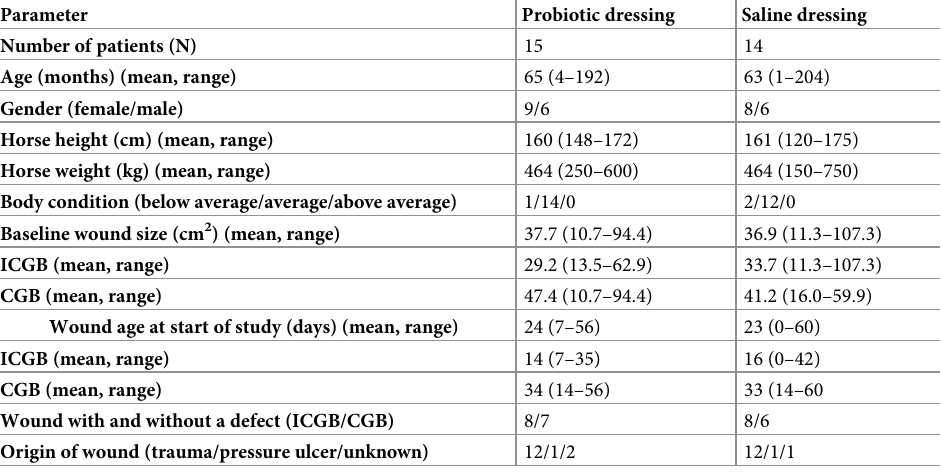
Table 1. Patient demographics and baseline wound recordings of the 29 warmblood horses included in the study. Parameter Probiotic dressing Saline dressing Number of patients (N) 15 14 Age (months) (mean, range) 65 (4–192) 63 (1–204) Gender (female/male) 9/6 8/6 Horse height (cm) (mean, range) 160 (148–172) 161 (120–175) Horse weight (kg) (mean, range) 464 (250–600) 464 (150–750) Body condition (below average/average/above average) 1/14/0 2/12/0 Baseline wound size (cm 2 ) (mean, range) CGB (mean, range) Wound age at start of study (days) (mean, range) 24 (7–56) 23 (0–60) ICGB (mean, range) 14 (7–35) 16 (0–42) CGB (mean, range) 34 (14–56) 33 (14–60 Wound with and without a defect (ICGB/CGB) 8/7 8/6 Origin of wound (trauma/pressure ulcer/unknown) 12/1/2 12/1/1 ICGB = incomplete granulation bed; CGB = complete granulation